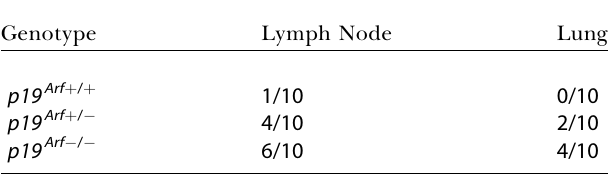
Table 1. Metastatic Frequency of SCC Genotype Lymph Node